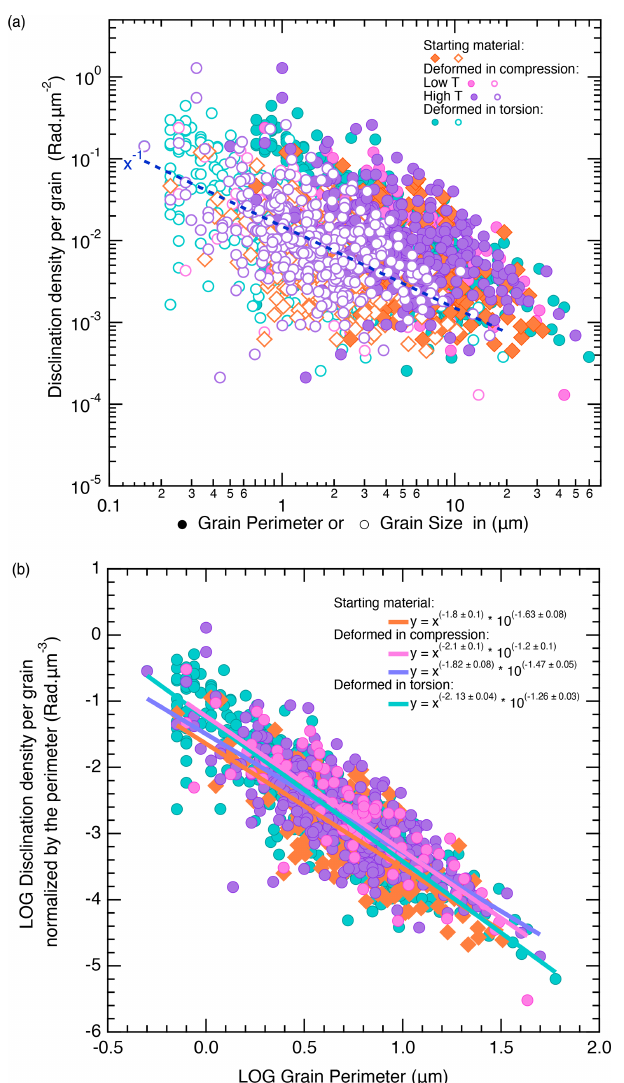
Figure 12. (a) Distribution of disclination densities (one point per grain) as a function of the grain size (hollow symbol) or grain perimeter (full symbol) in the starting material (CMT-16-7), in two samples deformed in axial compression (at low temperature for CMT-17-2 and at high temperature for CMT-16-9-SII) and in one sample deformed in torsion (PI0546-III). The step size is 0.1 µm (original acquisition step size). The dashed dark-blue line is a guide for the eye with a y = x − 1 function. (b) Distribution of one-point- per-grain disclination densities normalized to the grain perimeter as a function of the grain perimeter in the starting material (CMT-16-7) in two samples deformed in axial compression (at low temperature for CMT-17-2 and at high temperature for CMT-16-9-SII) and in a sample deformed in torsion compression (PI0546-III). Also shown is the least-squares fit through each sample data set and the equation of the fit. See main text for details.